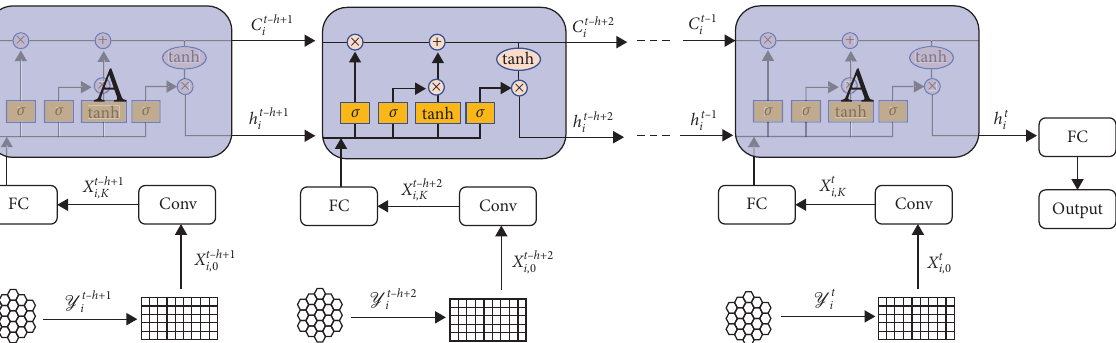
Figure 2: The architecture of